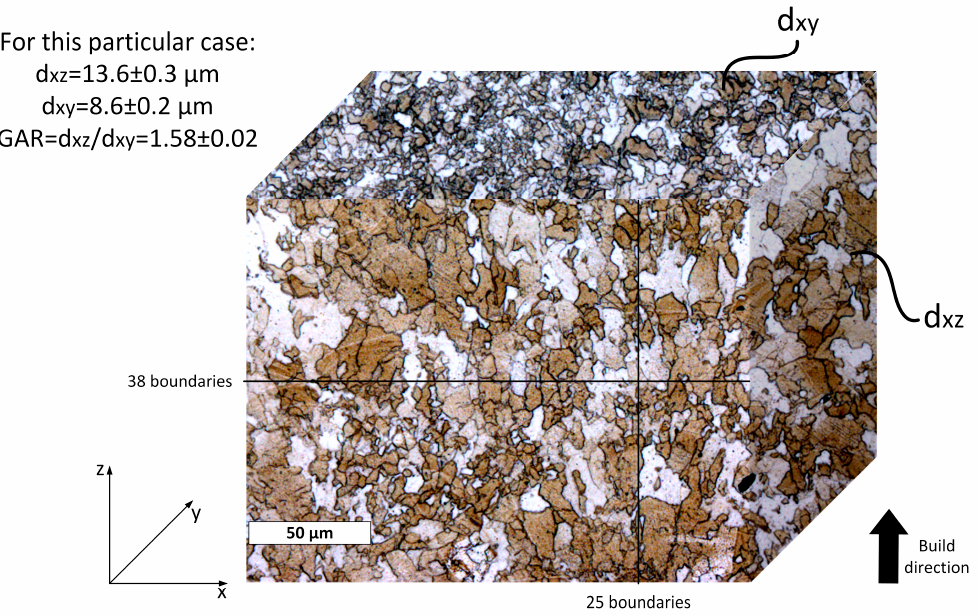
Figure 7. Metallography of Specimen 1 using a LEXT 4100 confocal microscope ( × 500).